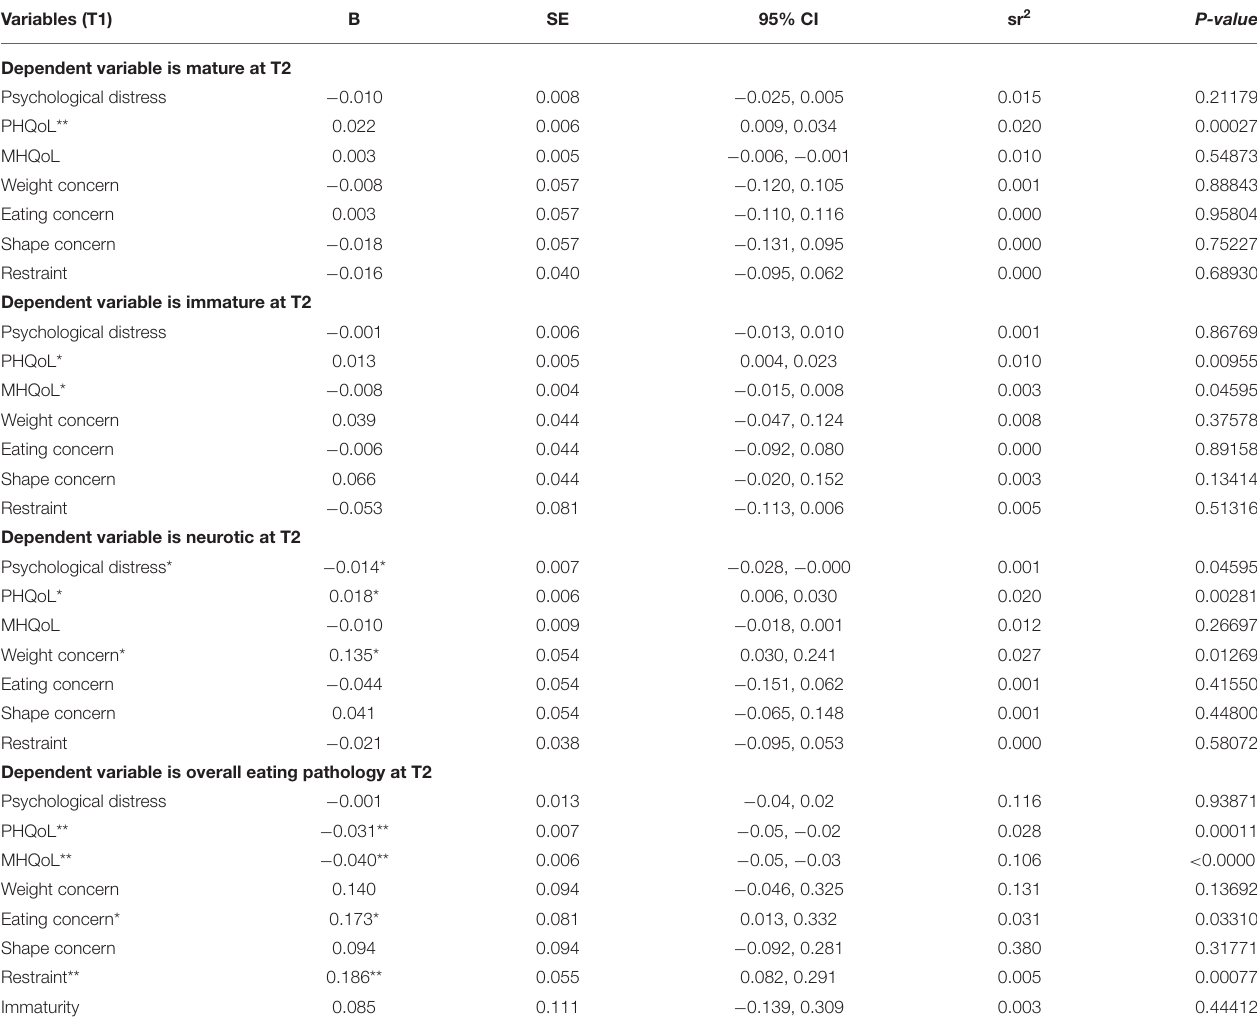
TABLE 2B | Influence of psychological distress, HRQoL, and eating pathology at T1 on defence-styles at T2. Variables (T1) B SE 95% CI sr 2